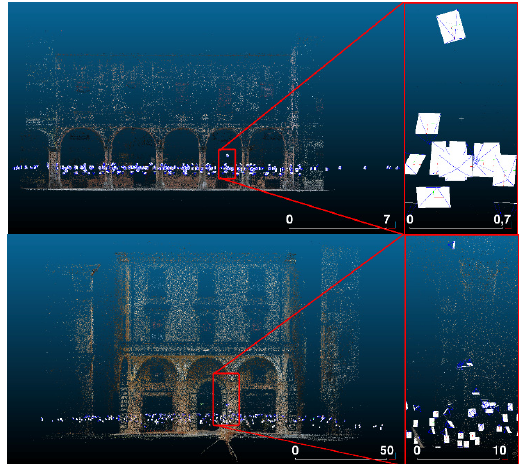
Figure 1. Examples of image-based 3D reconstruction results of complex architectural scenarios achieved with the presented